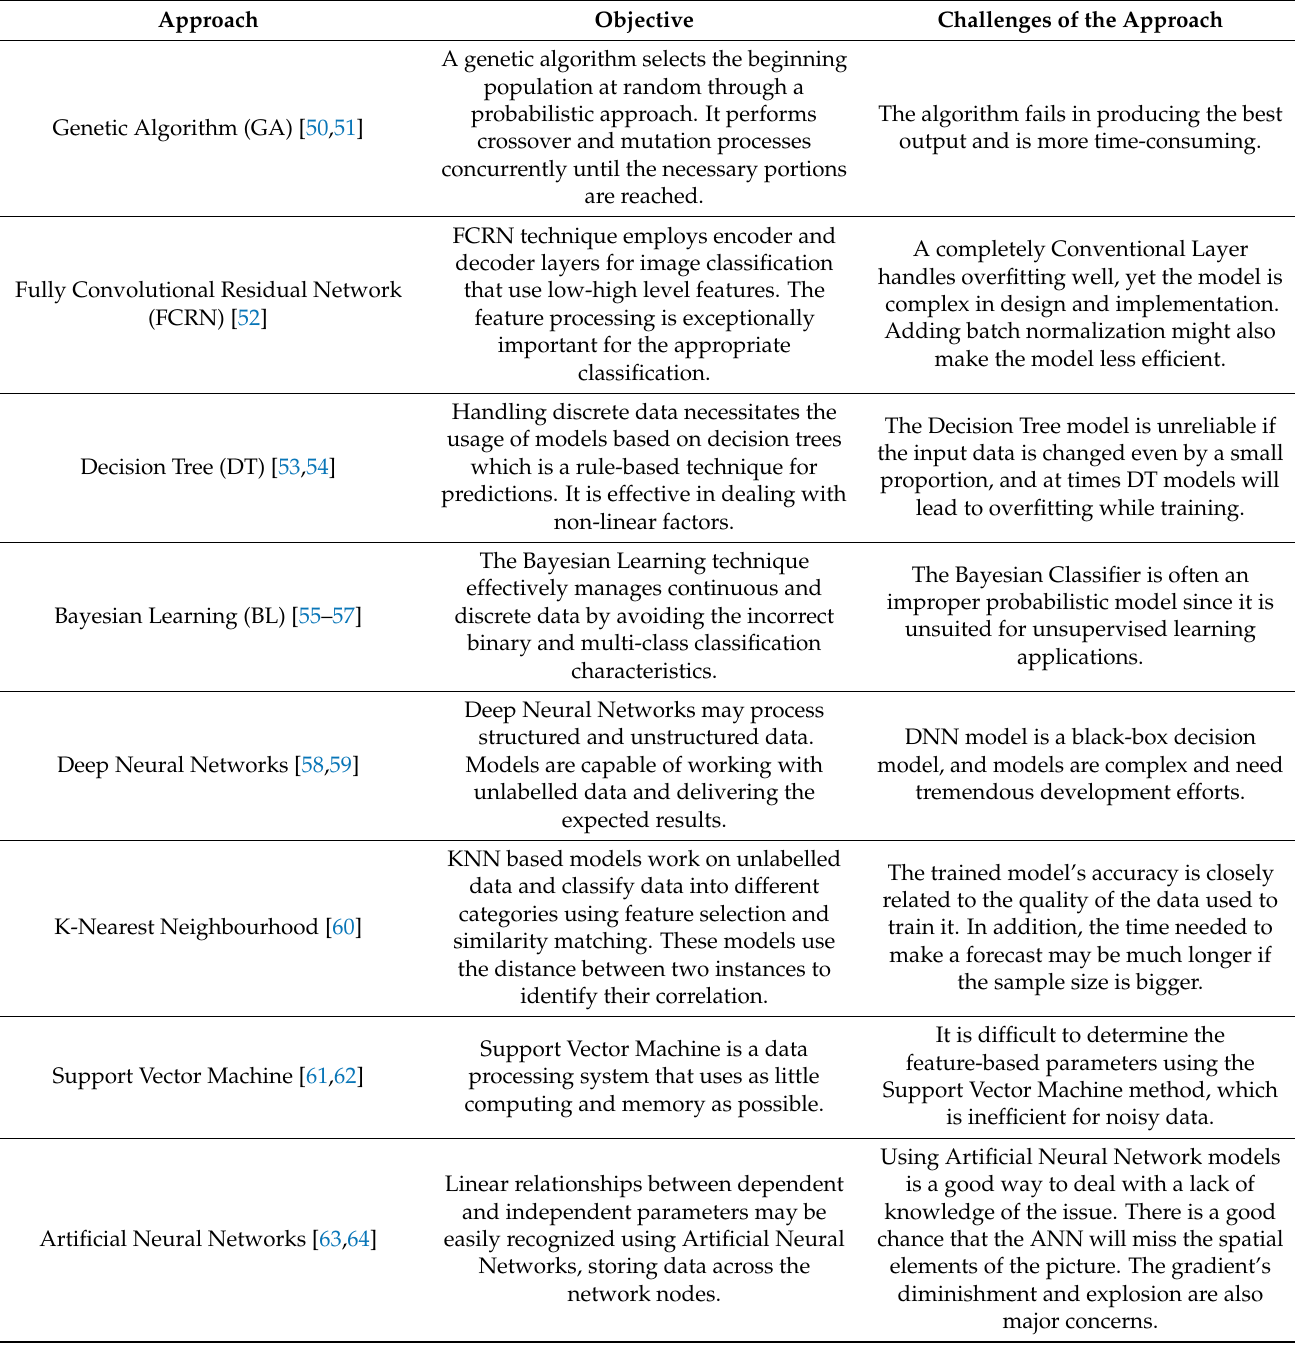
Table 1. A detailed description of the various models in image